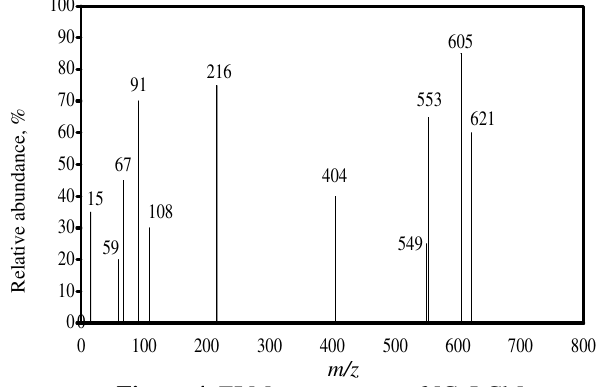
Figure 4. EI Mass spectrum of [CoLCl